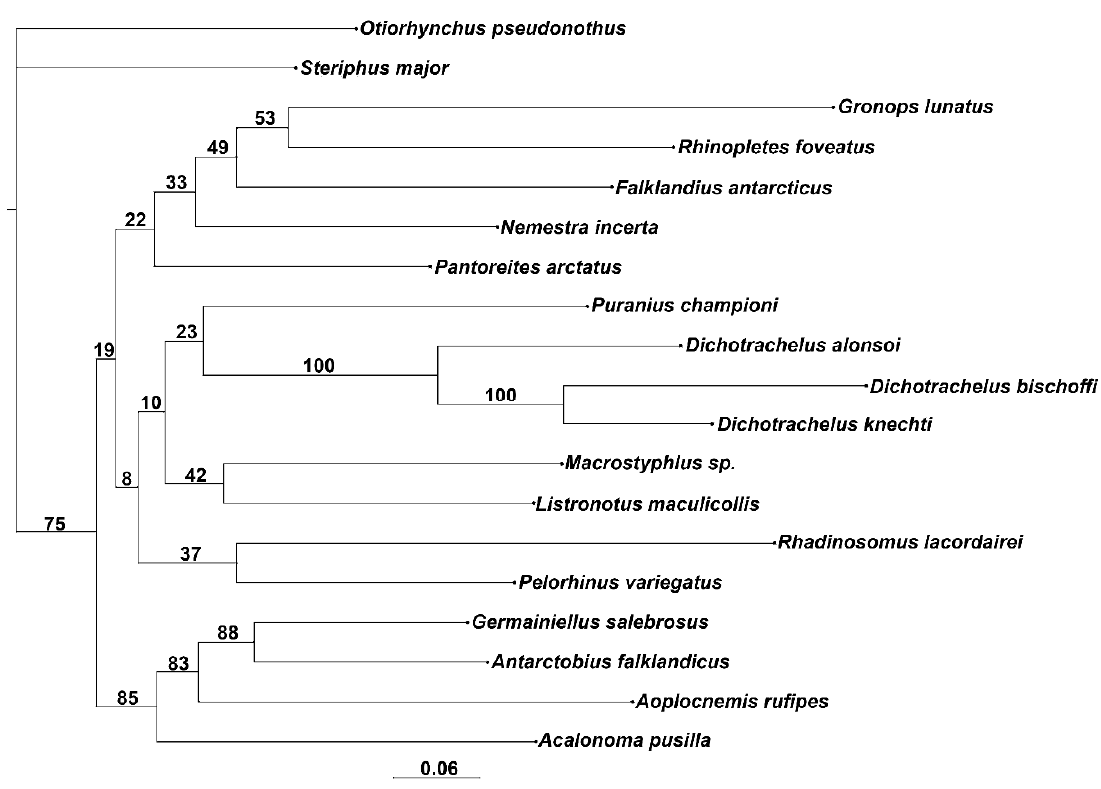
Figure 8. Mitochondrial cytochrome oxidase I analysis, Cyclominae. Bayesian Inference consensus tree. Numbers above branches indicate posterior probability. Scale bar unit: expected substitutions per site.